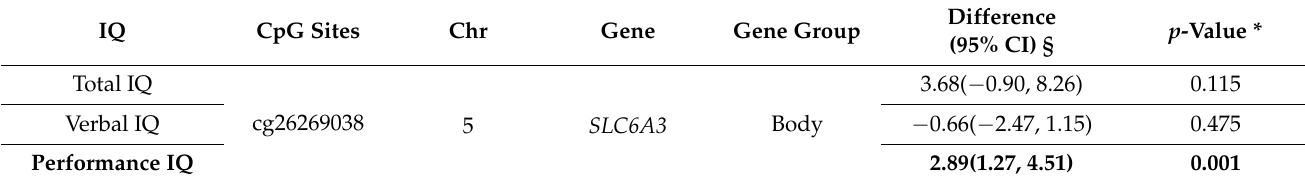
Table 3. Association between selected CpG sites and children’s Performance IQ ( n = 59)